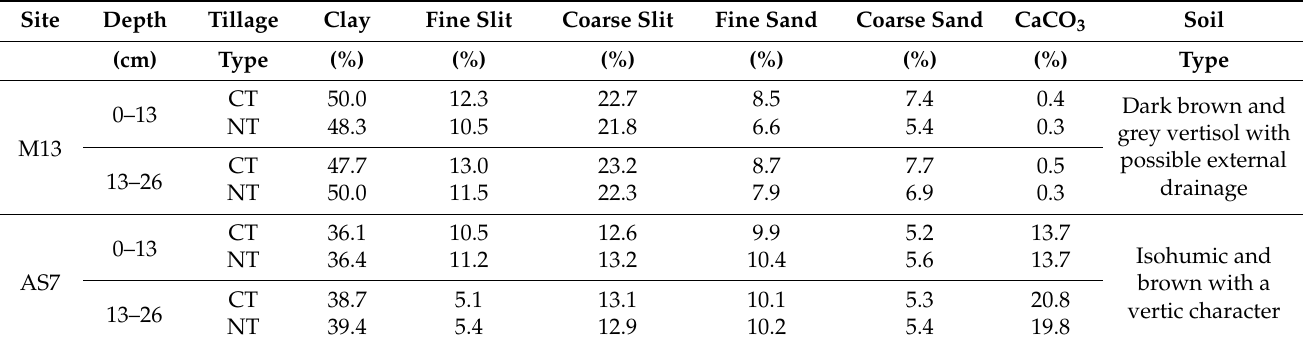
Table 1. The soil granulometry characteristics of the NT and CT systems.